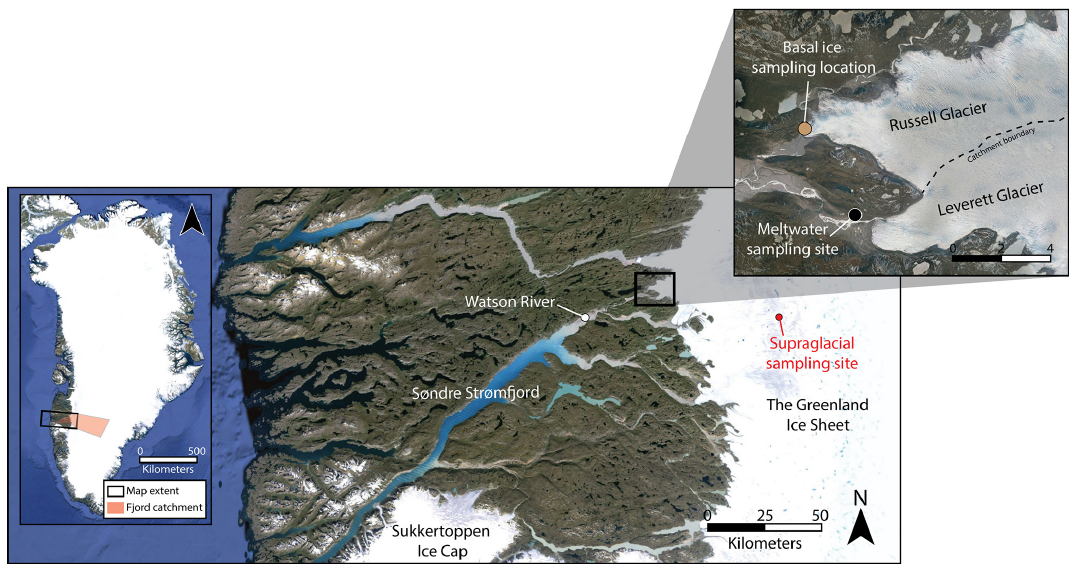
Figure 1. Map showing the study area, including the location of Leverett Glacier runoff sampling station (white dot), surface sampling site (red dot) and the basal ice sampling location (brown dot), together with Søndre Strømfjord and the Watson River, into which runoff from Leverett Glacier